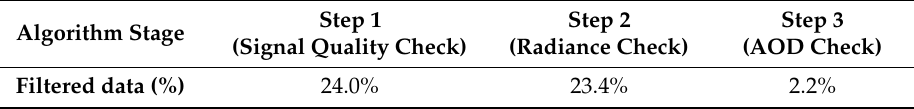
Table 1. Ratio (%) of ZEN-R52 filtered data at each step of the ZEN-QC